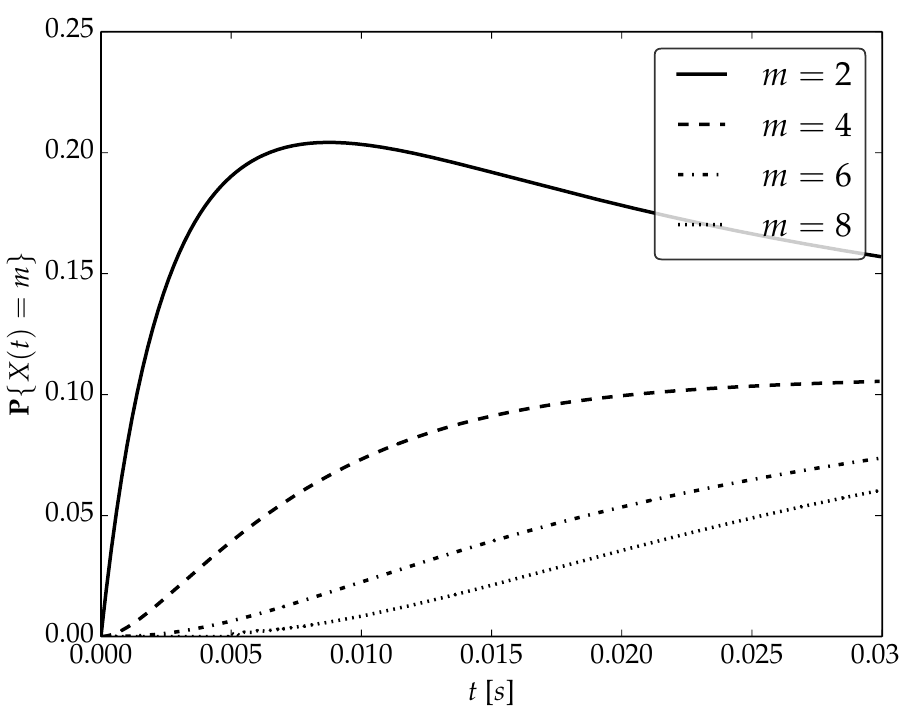
Figure 2. Transient distributions P { X ( t ) = m } for N = 2, batch distribution P 1 and ρ = 1.